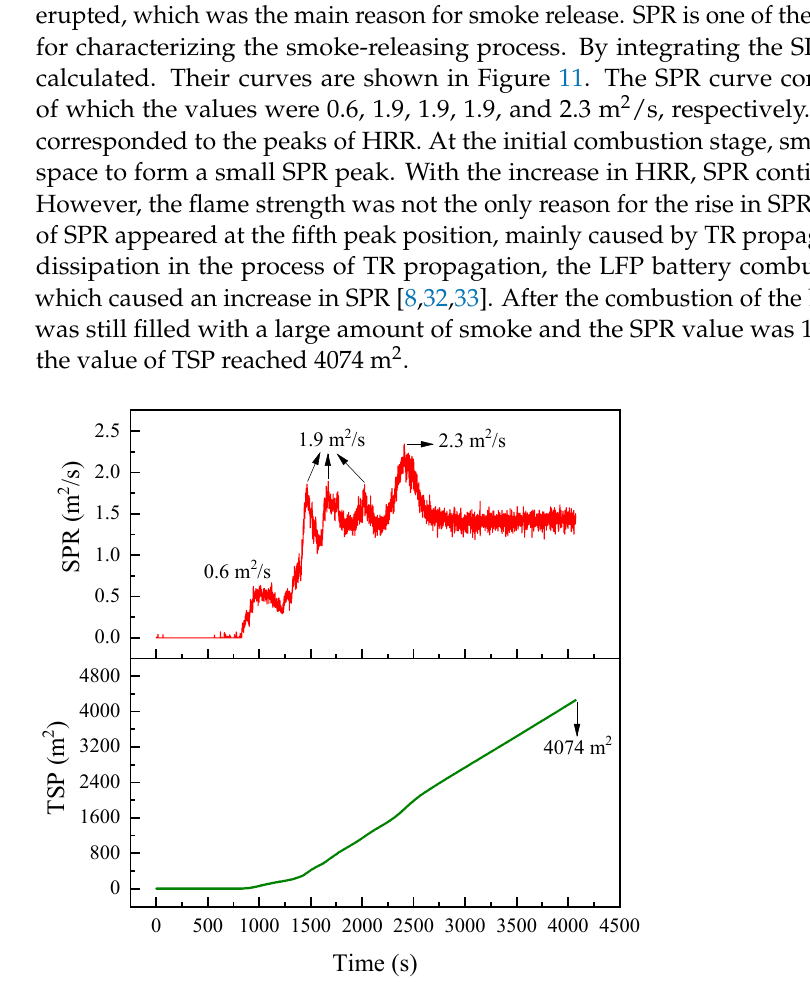
8.87 Figure 12. Photograph of the LIB pack after the combustion test. 3.5. Hazards Analysis of LIB Pack Combustion Table 2 compares this study’s combustion features of fully charged LIBs with previ- ous research. With the increased battery capacity for the TR process of a single LFP bat- tery, the combustion time, normalized THR, and normalized mass loss were reduced, in- dicating that the degree of combustion for LFP batteries would decrease. However, the heat release was more concentrated and the internal heat was more challenging to release,